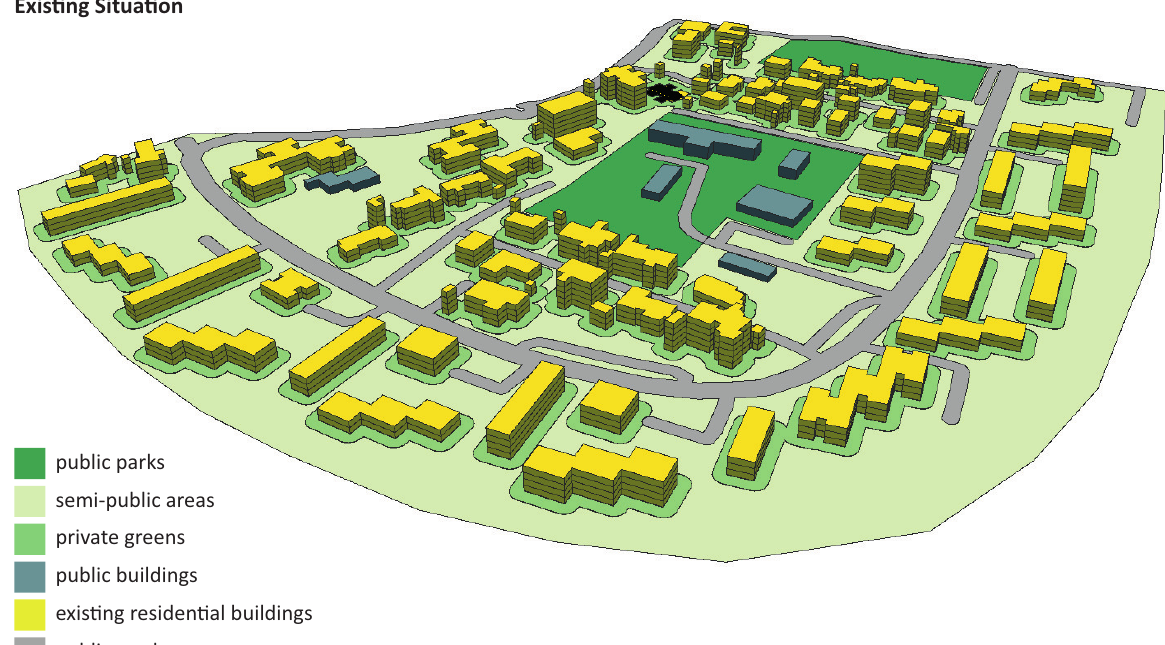
Figure 2. Current status of the “boot” neighborhood in Hatzor